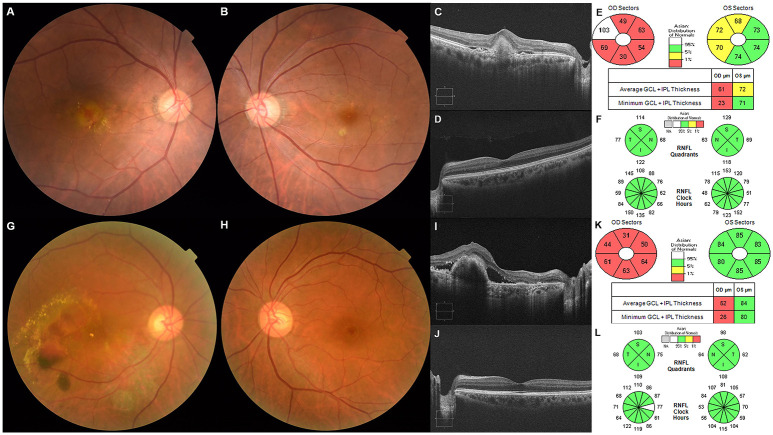
Fundus photography (A, B, G, H), optical coherence tomography images including line scan (C, D, I, J), ganglion cell—inner plexiform layer (GC-IPL) analysis map (E and K), and retinal nerve fiber layer (RNFL) analysis map (F and L) of representative cases showing unilateral exudative age-related macular degeneration.Typical choroidal neovascularization (tCNV) was observed in the right eye (A and C), and drusen and the focal depigmented lesion were noted in the left eye (B and D). The left eye (G and I) was diagnosed with polypoidal choroidal vasculopathy (PCV), and there was no abnormal finding in the right eye (H and J). The average GC-IPL and RNFL thickness was 72μm and 95μm in the fellow eye with tCNV, and 84μm and 97μm in the fellow eye with PCV, respectively.